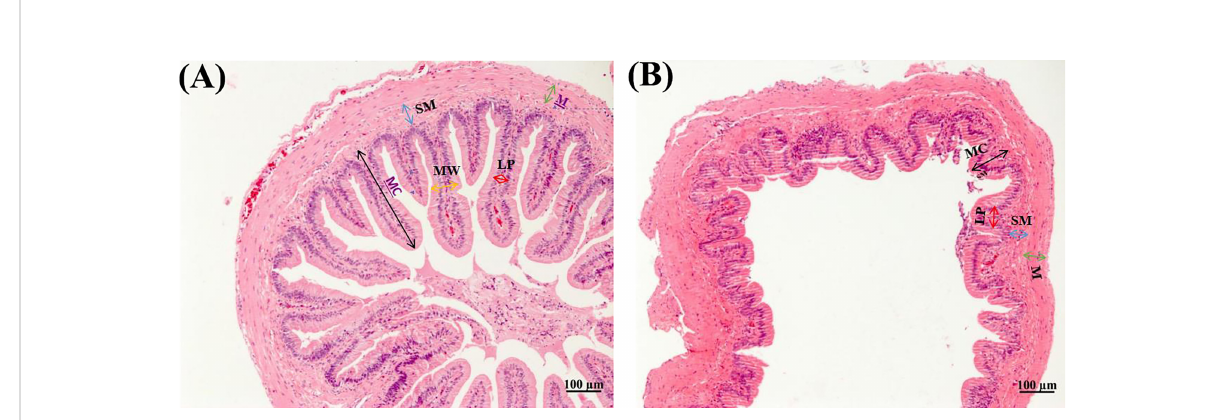
FIGURE 3 Morphology of small (A) and large (B) intestines of juvenile P. sinensis